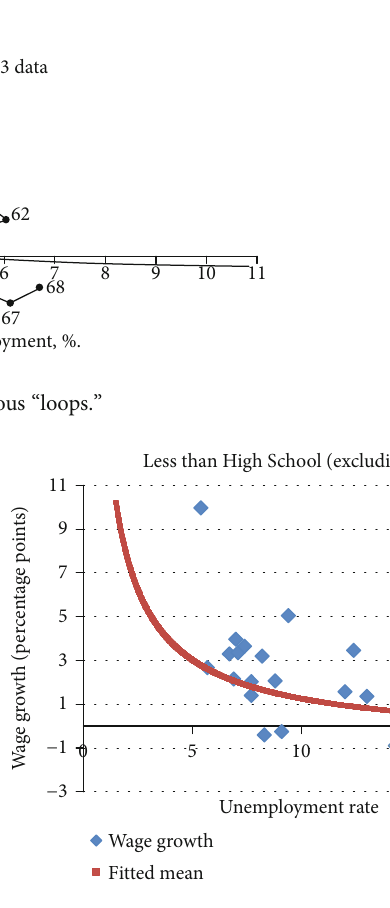
Figure 8: Less Than High School (excluding 2010).